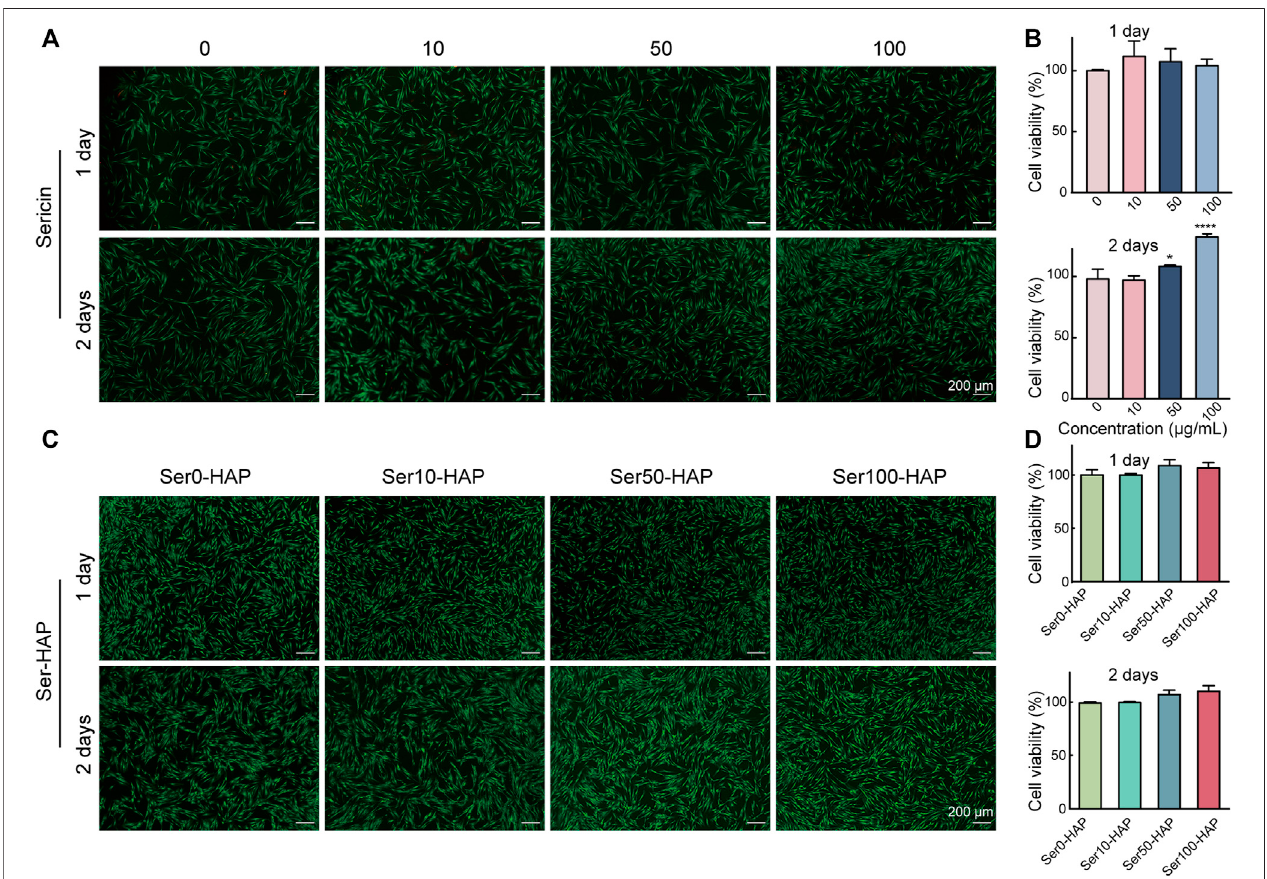
FIGURE 3 | Cytocompatibility of sericin solution and the Ser-HAP particles. (A) Live/Dead staining and (B) CCK-8 assay of sericin at 1 and 2 days; (C) Live/Dead staining and (D) CCK-8 assay of Ser-HAP particles at 1 and 2 days.